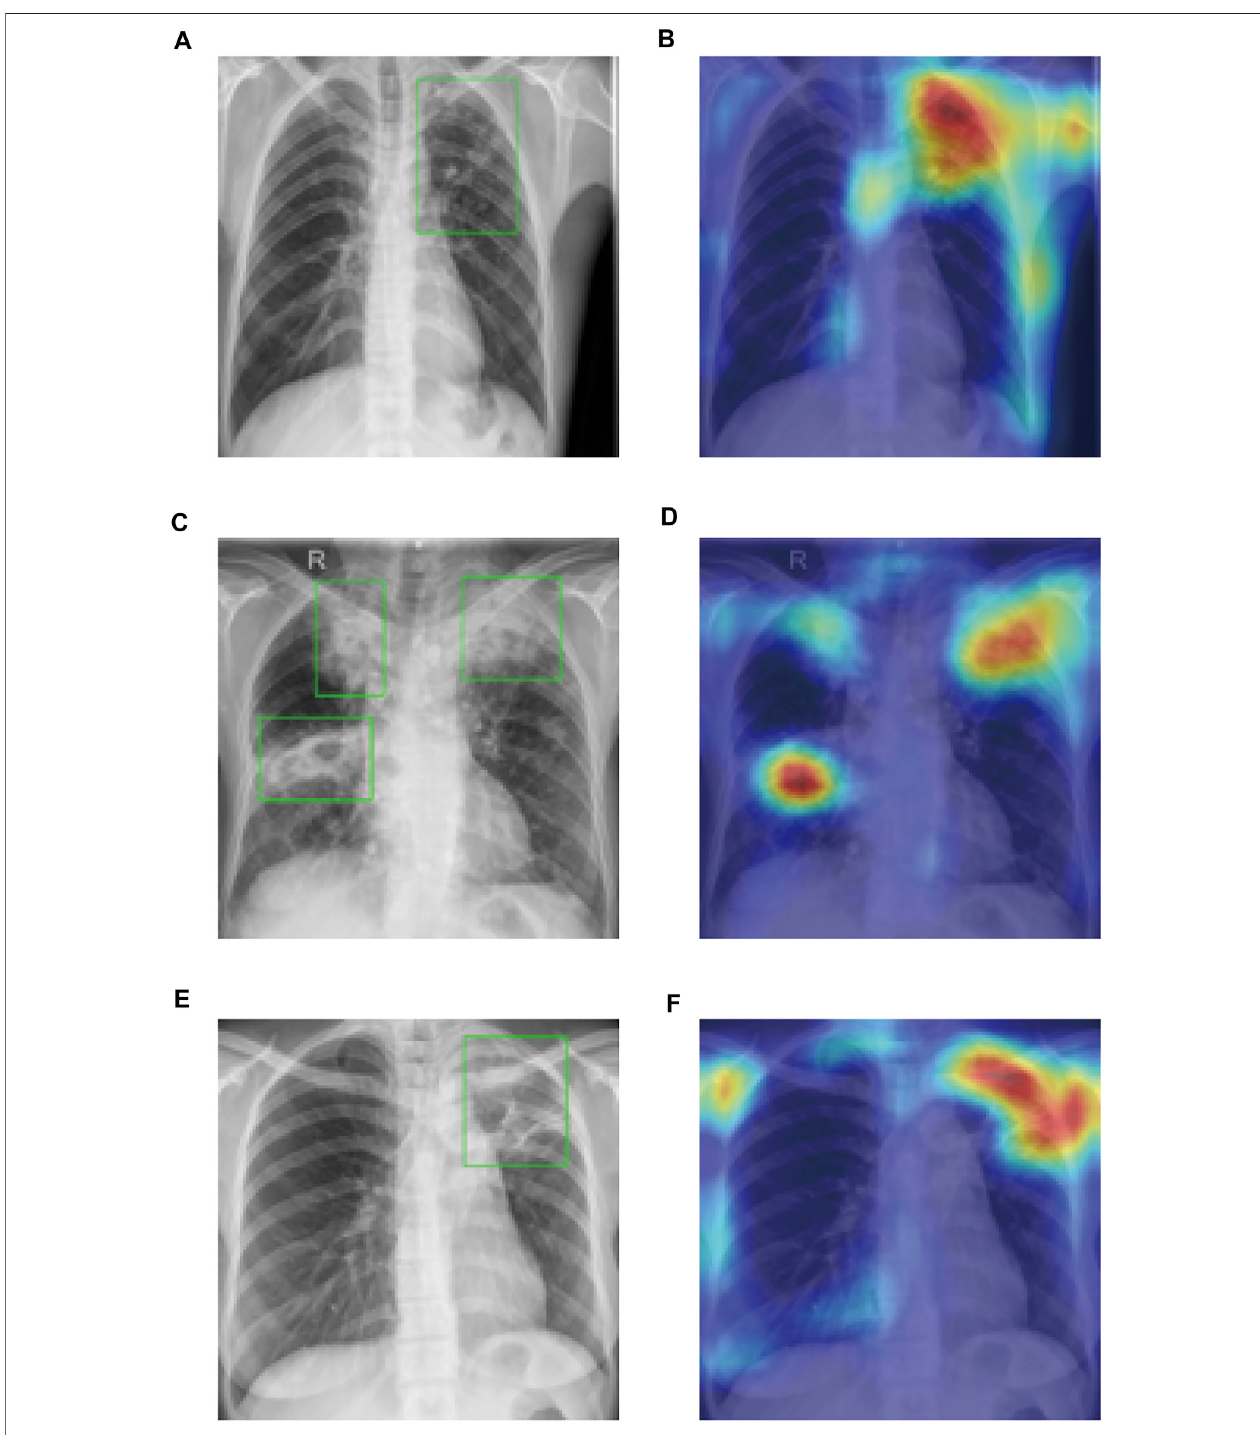
FIGURE 5 | CAMs generated by ResNet matched the precise regions of TB abnormalities. Bounding boxes [in (A,C,E) ] meant the regions of abnormalities identi fi ed by doctors and hot regions [in (B,D,F) ] showed the discriminative regions generated by AI algorithm.